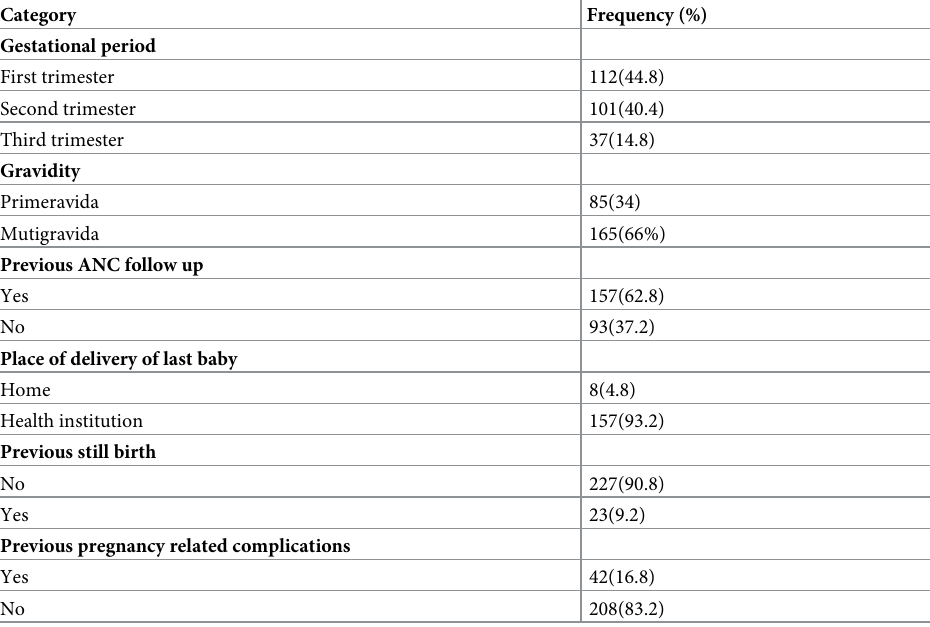
Table 2. Obstetrics characteristics of study participants, 2019(n =